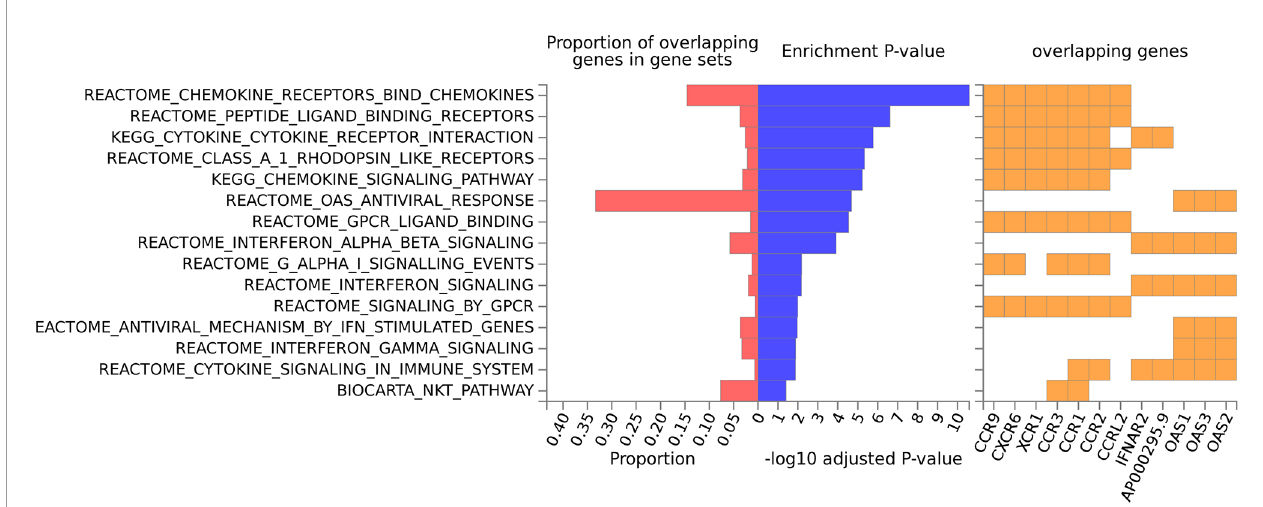
FIGURE 4 | Canonical pathway analyses of the set of COVID-19 risk